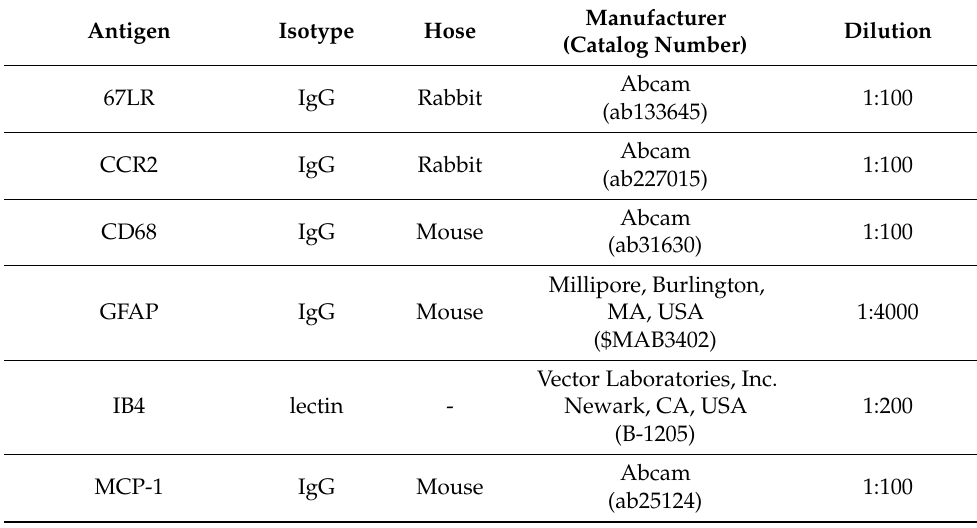
Table 1. Primary antibodies used in the present